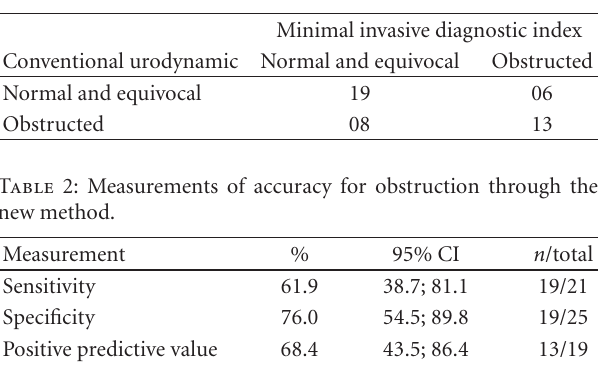
Table 1: Comparison between Abrams-Gri ffi ths equation (conven- tional invasive urodynamic) and minimal invasive diagnostic index.